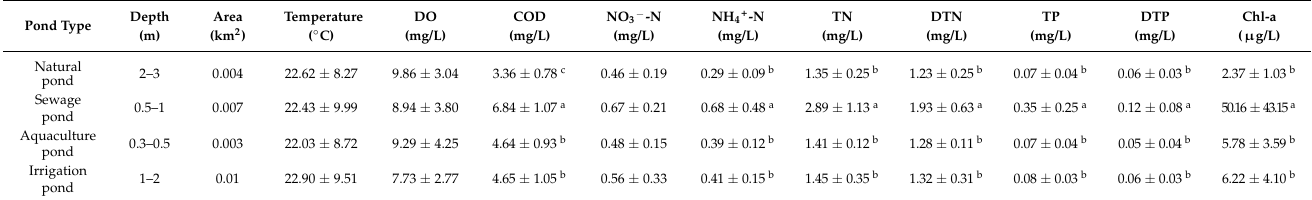
Table 1. Key aquatic environment variables at different ponds of the Tongyang River watershed during pond-survey period. The presented values are the mean ± standard deviation. Different letters indicate significant differences at p < 0.05 across pond types.